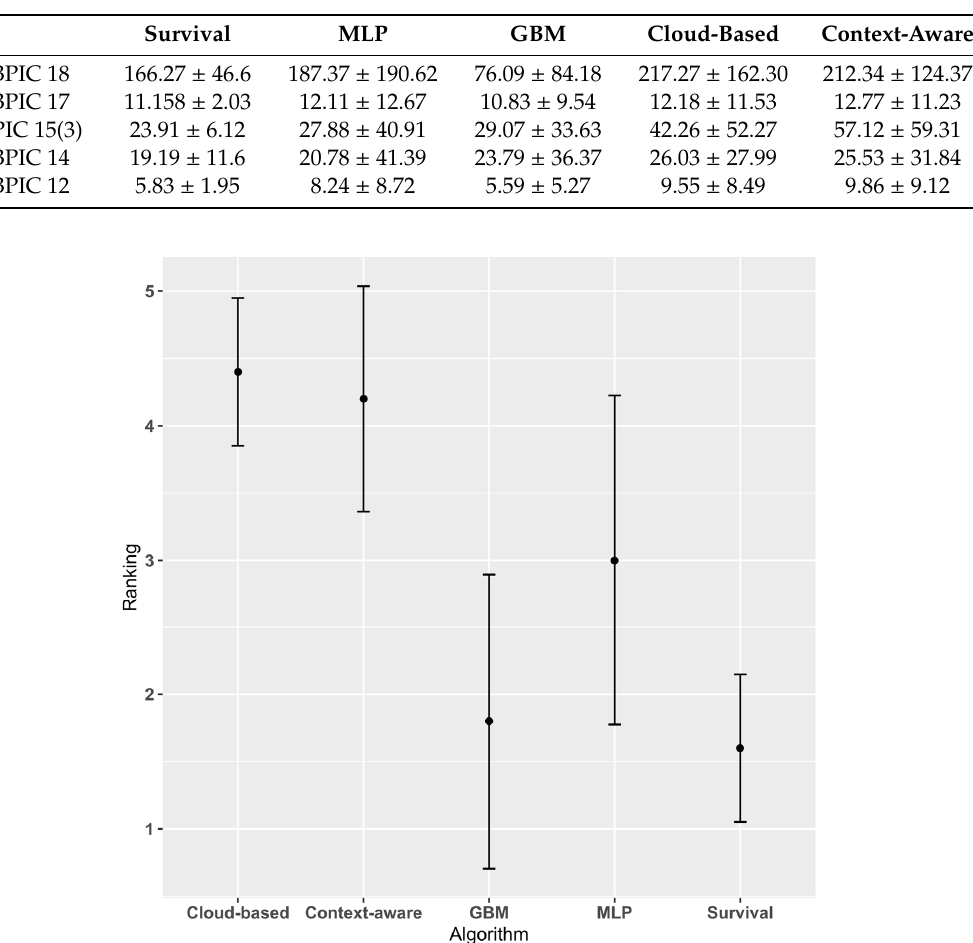
Figure 4. Average Algorithm Ranking with associated error bars.